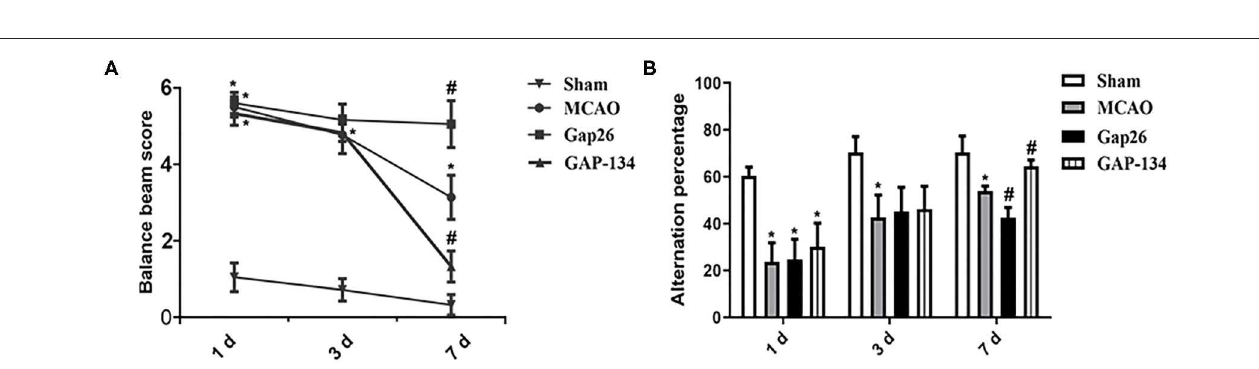
FIGURE 1 | Expression levels of both Cx43 and p-Cx43 were detected at 3, 7, and 14 d after MCAO. Data were presented as mean ± SEM, n = 6. Representative Western blot bands and schematic diagram showed that total Cx43 (A,C) , p-Cx43 (B,D ), and ratio of p-Cx43/Cx43 (E) were increased after MCAO and peaked at 7 d (* P < 0.05 vs. sham).